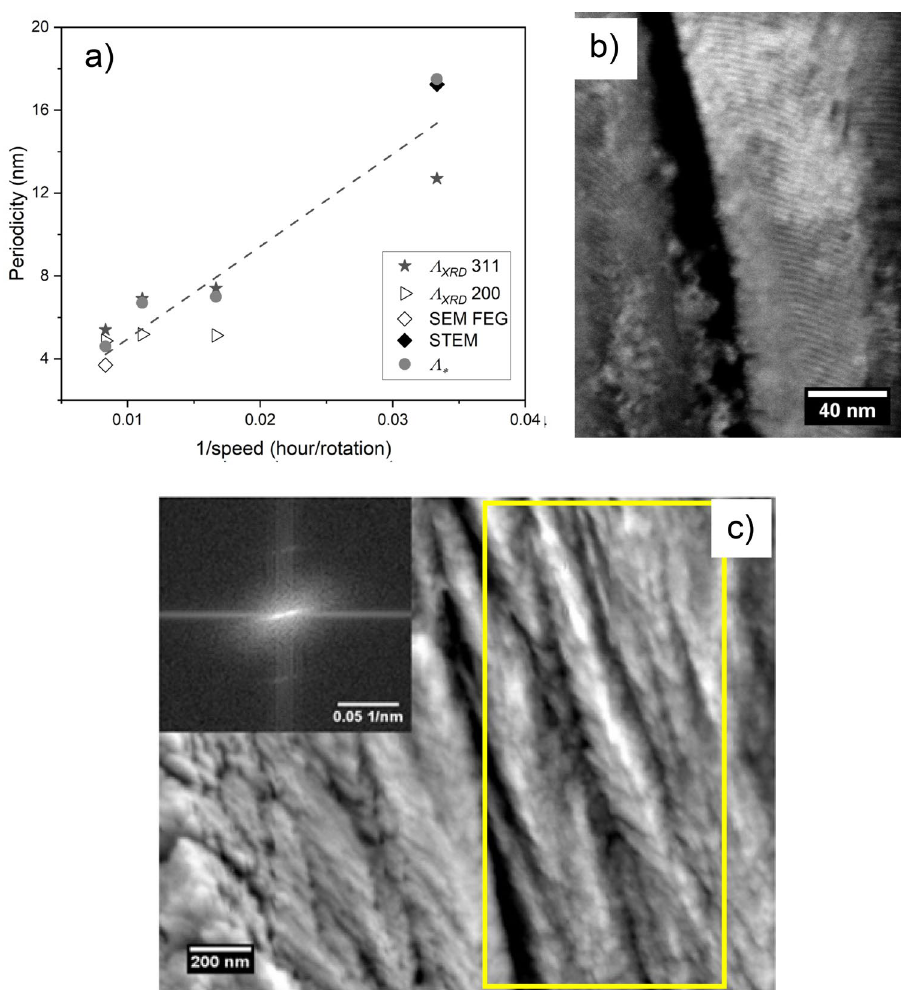
Figure 8. ( a ) Effect of the carousel rotational speed on the multilayer periodicity according to four distinct methodologies for CrN/Cr 1-x Al x N multilayers manufactured at a constant bias level (− 150 V), ( b ) STEM micrograph acquired from the multilayer deposited at − 150 V and 0.5 rpm, and ( c ) High-resolution FEG-SEM micrograph acquired from the cross-section of the multilayer deposited at − 150 V and 2.0